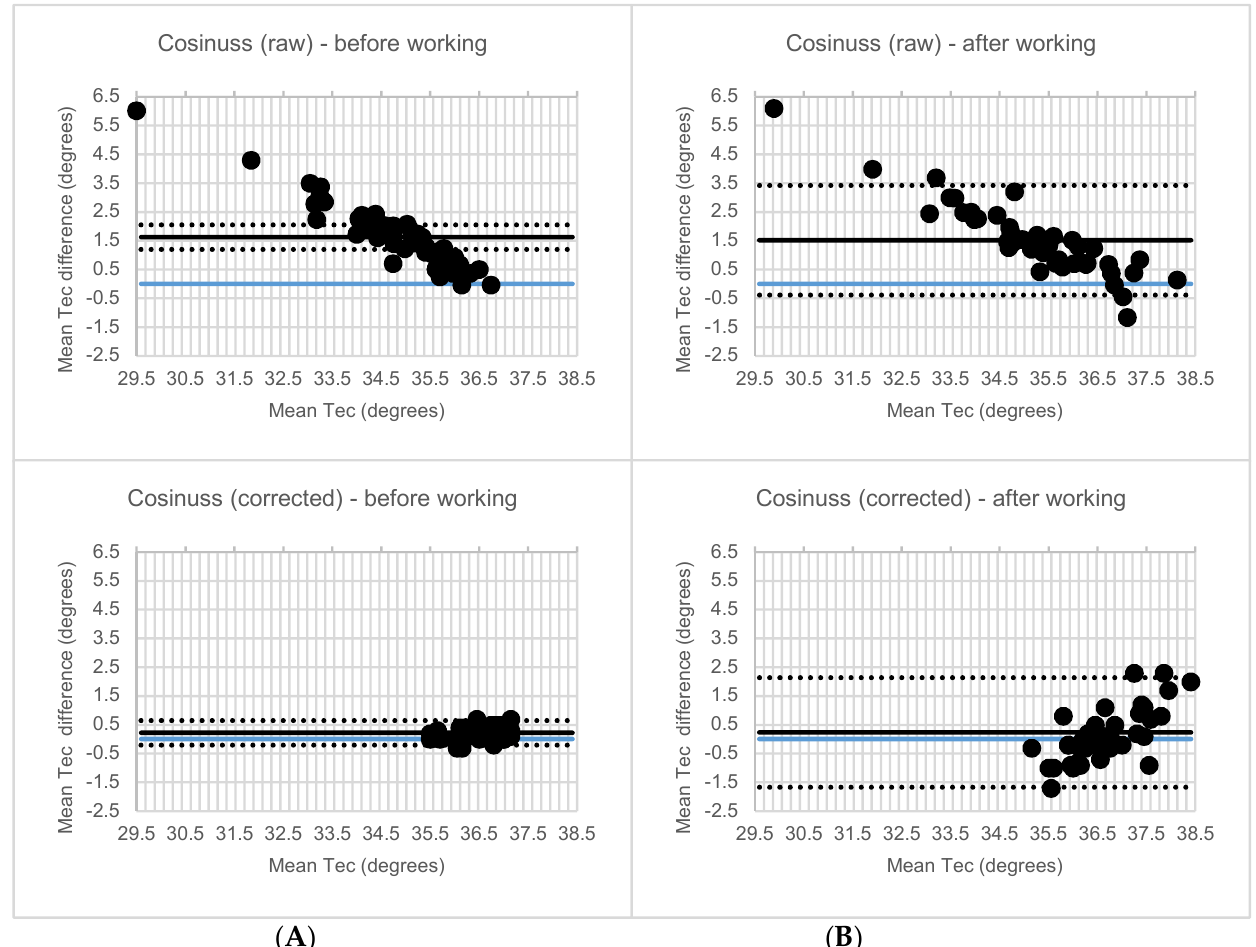
Figure 5. Bland-Altman plots of the mean ear canal temperature versus the mean temperature difference. The ear canal temperature (T EC ) raw and corrected Cosinuss° ( A ) before and ( B ) after working compared to the IR thermometer with mean and upper and lower limit of agreement (LoA).